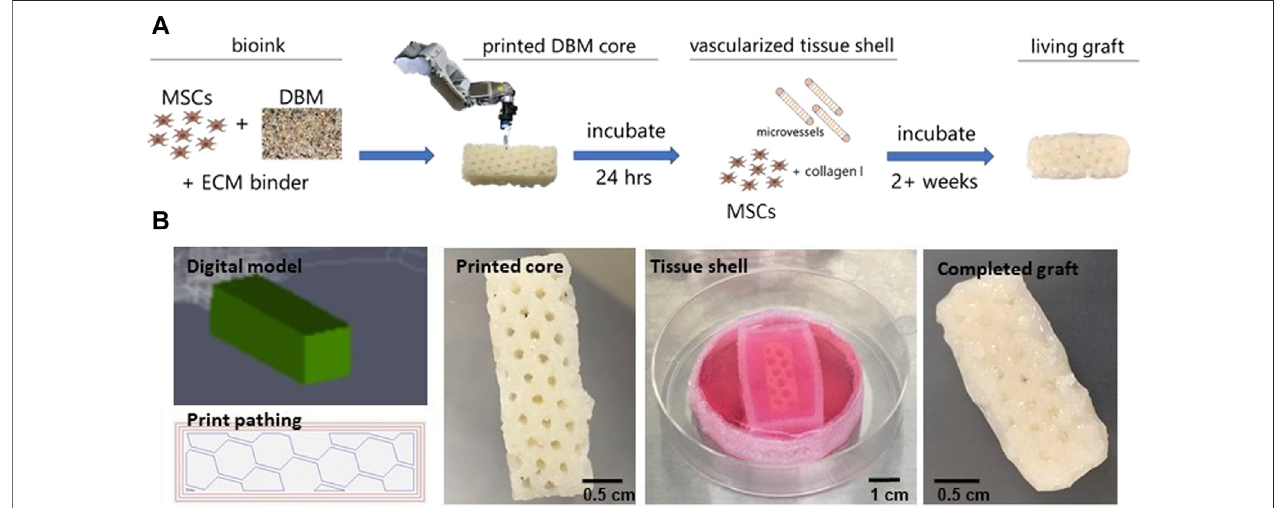
FIGURE 1 | Fabrication of graft core and vascularized tissue shell. (A) Schematic of the graft fabrication work fl ow resulting in a printed graft surrounded by a vascularized, tissue shell. (B) Fabrication ofthe graft starting with (left to right) the digital TSIM ® model and print path used in the 3D printing ofthe graft core, the printed coreasalatticed,1 cm×1 cmx3 cmcuboid,formationofthetissueshellandconditioningthegraft,andthecomplete,vascularizedgraftreadyforimplantation.MSC= mesenchymal stromal cell, DBM = demineralized bone matrix, ECM = extracellular matrix.